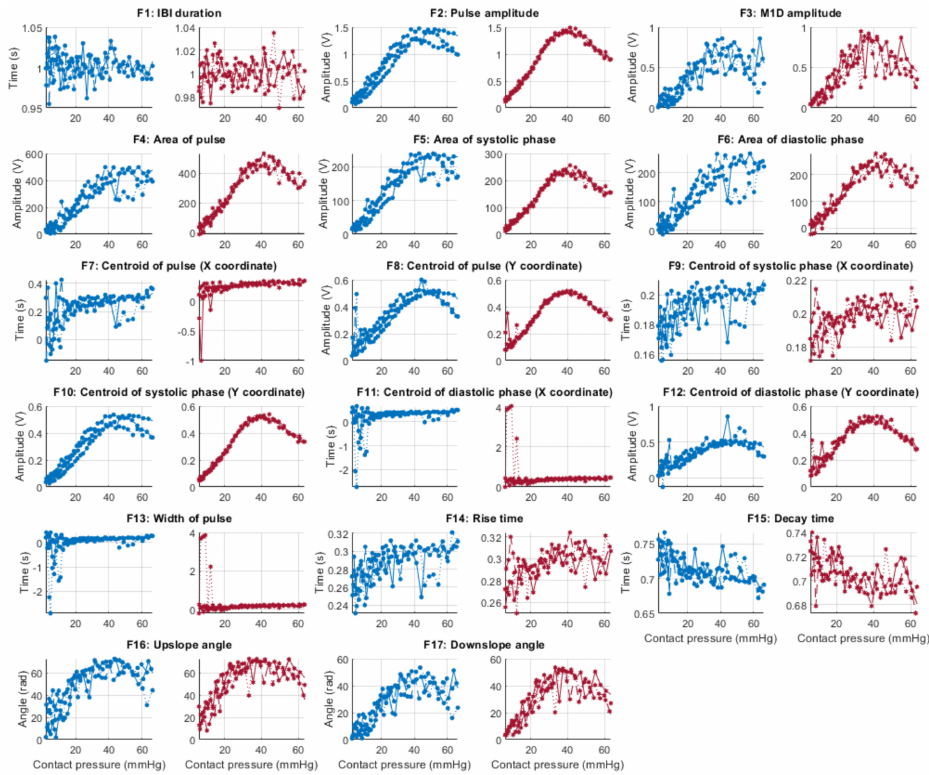
Figure 6. Behaviour of the extracted features during hypotension when compared against contact force. Blue lines: Infrared PPG-derived features. Red lines: Red PPG-derived